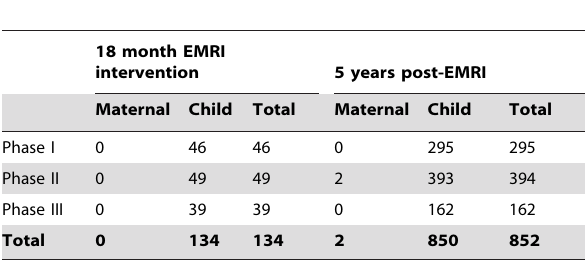
Table 3. Maternal and child lives saved in the catchment areas of the 30 health